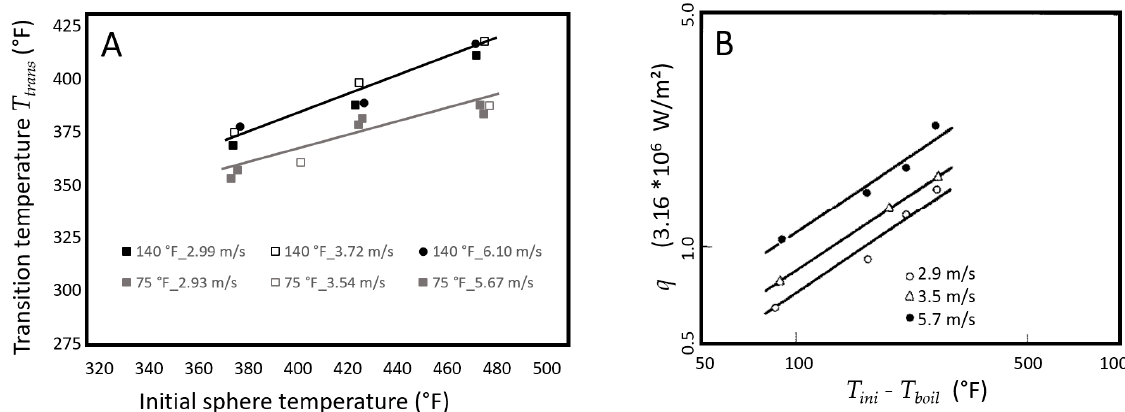
Figure 11. Effect of initial temperature ( T ini , X-axis) in transition boiling regime around a sphere (adapted from Reference [81]): ( A ) Transition temperature ( T trans , Y-axis) for different relative velocity ( ● / ▫ / ▪ ) and coolant temperature T l (grey/black; this trend later turned out to be erroneous); ( B ): The heat flux ( q , Y-axis) for different relative velocities.